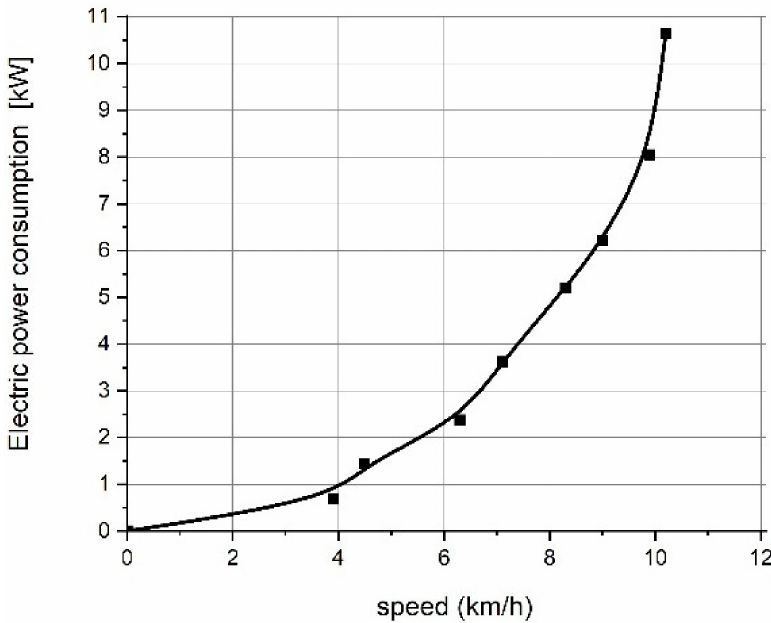
Figure 6. Estimation of electric power demand during sailing in favourable conditions—calm